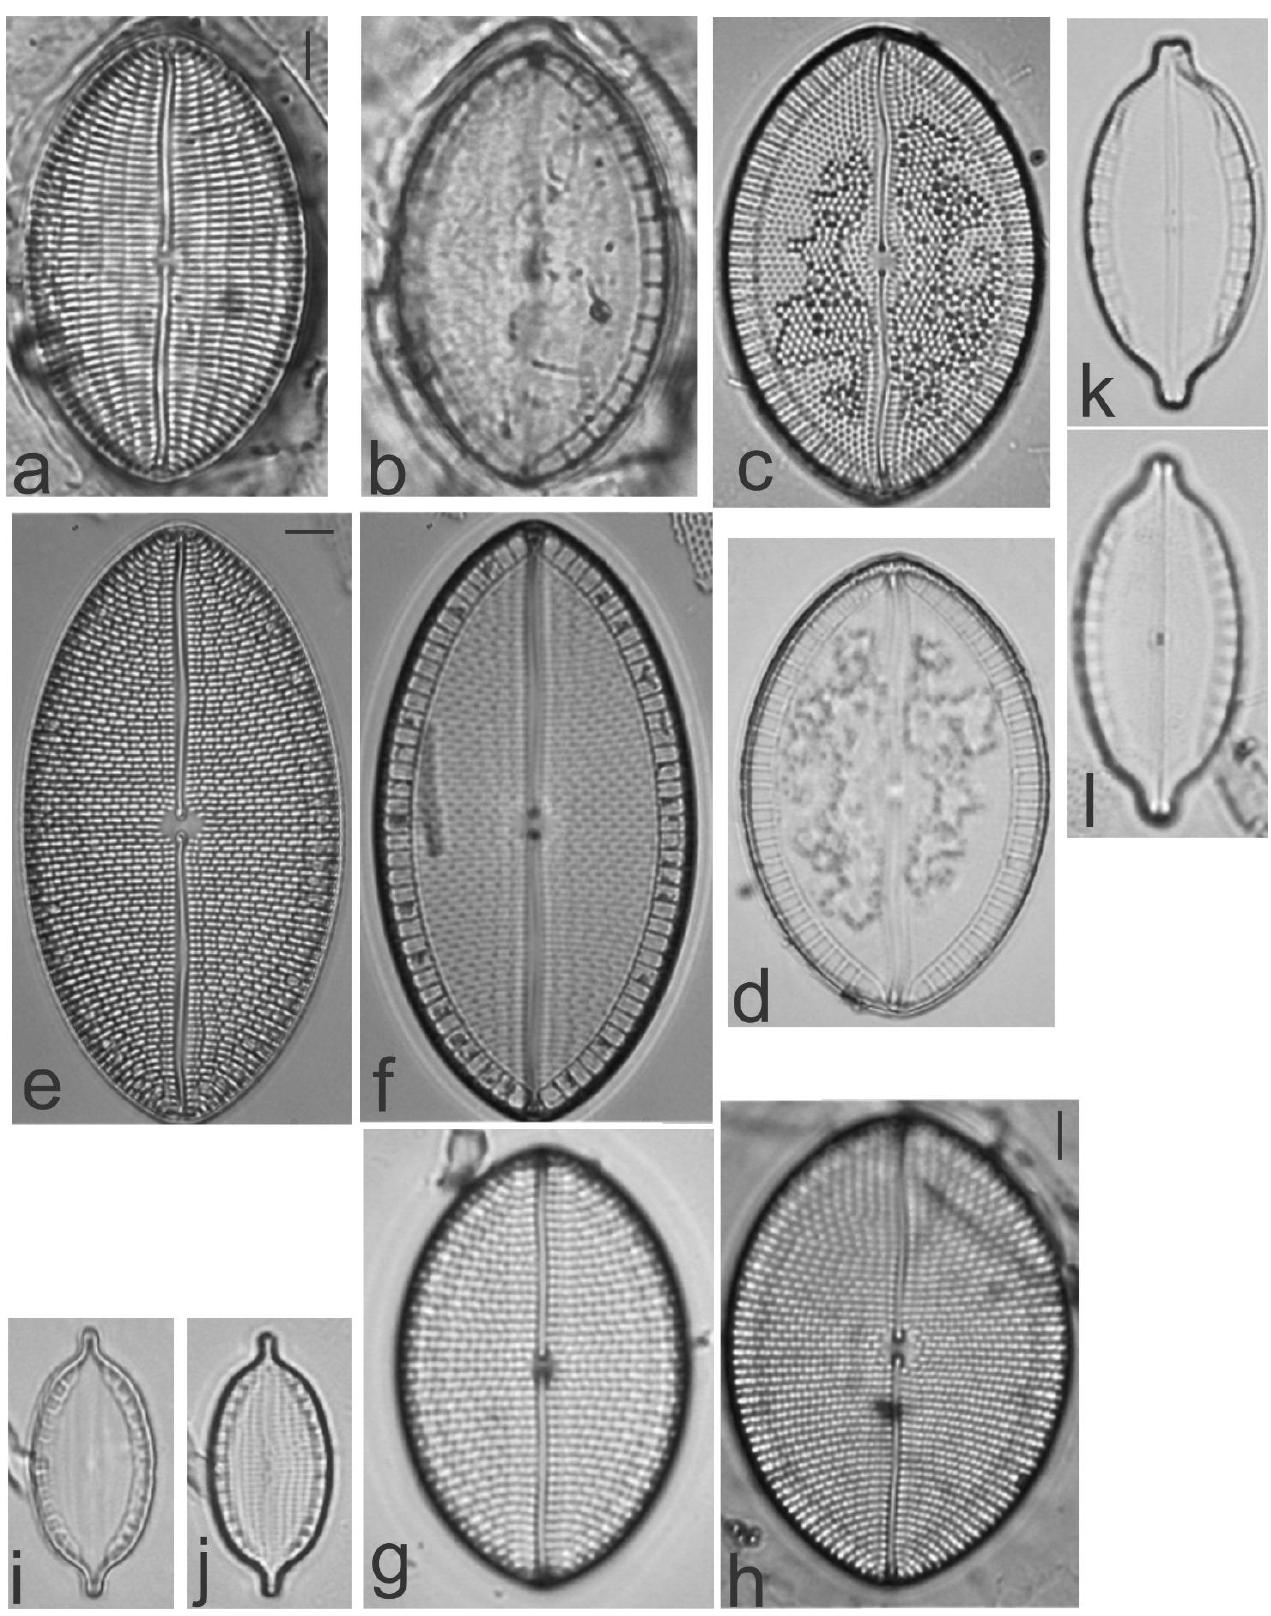
Figure 20. ( a – d ) Mastogloia ovata ; ( e – g ) M. ovum-paschale ; ( h ) M. pseudolatecostata ; ( i , j ) M. parva ; ( k , l ) M. decipiens . Scale bar = 5 μm.